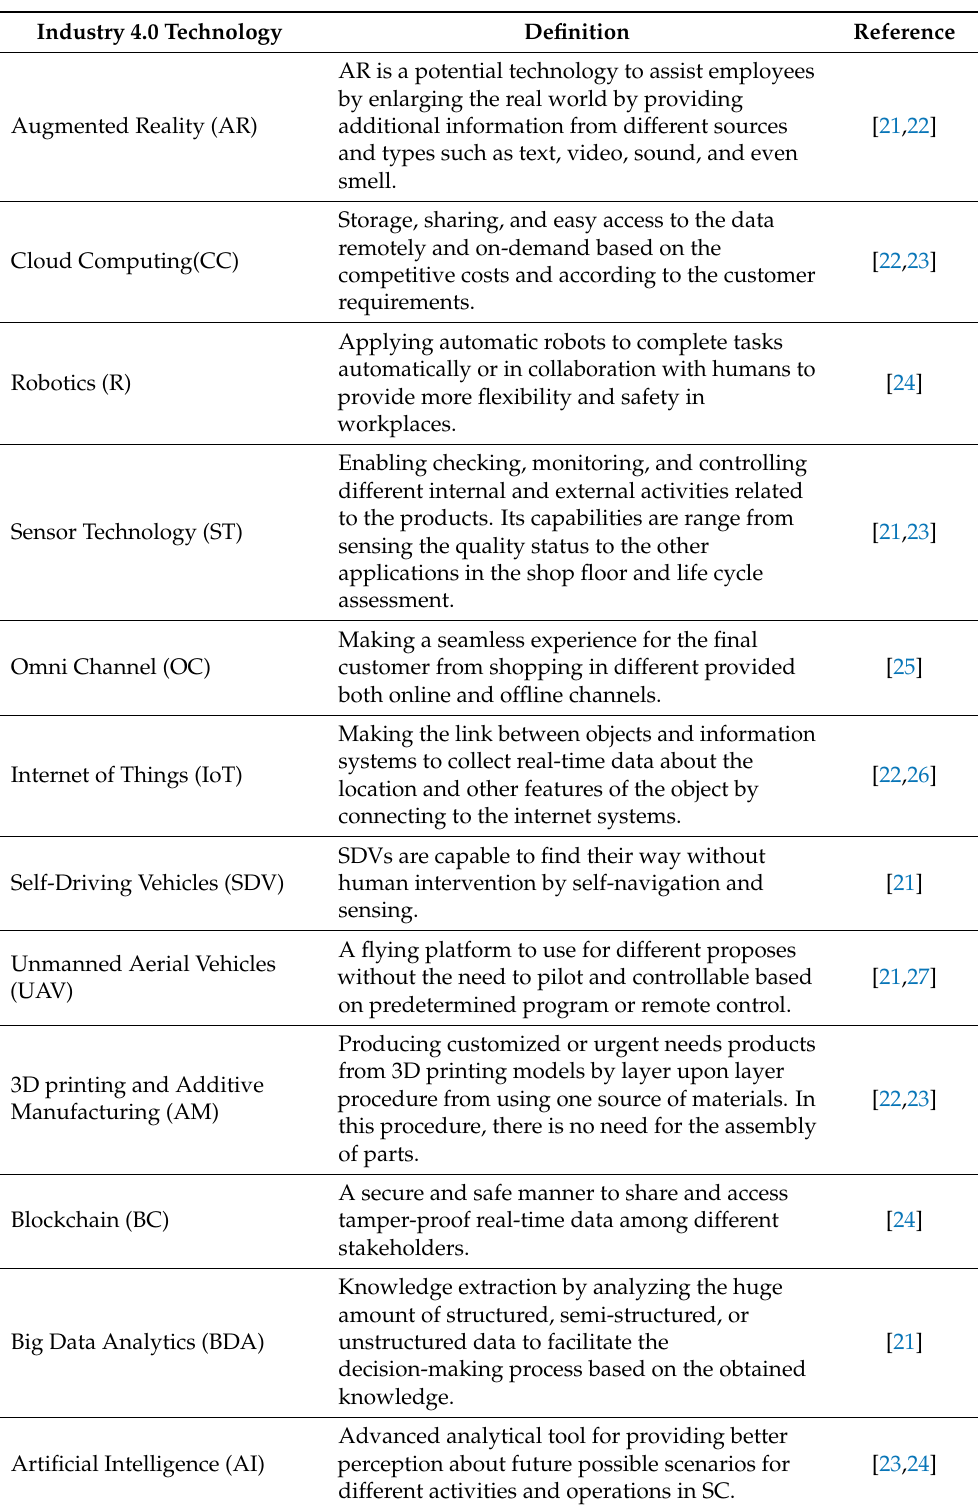
Table 1. Definition of Industry 4.0